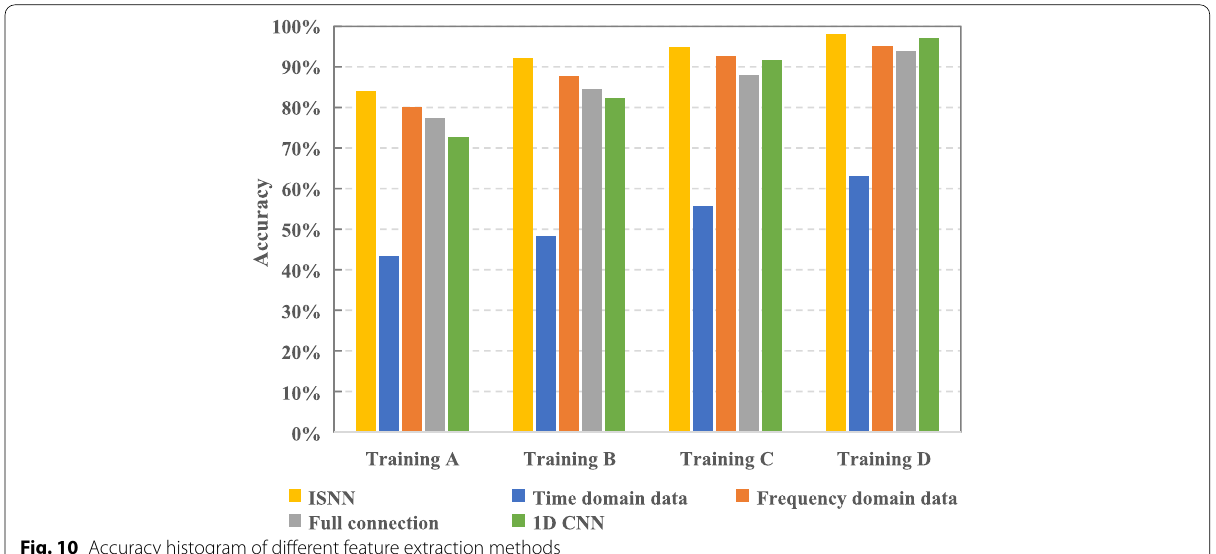
Fig. 10 Accuracy histogram of different feature extraction methods